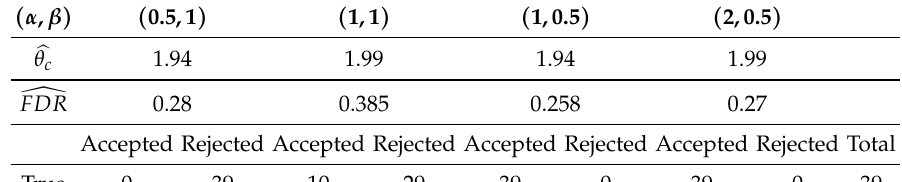
Table 4. Results for the model with Clayton copulas and for data corresponding to 80% of true null hypotheses to distinct values of the prior distributions of p i .